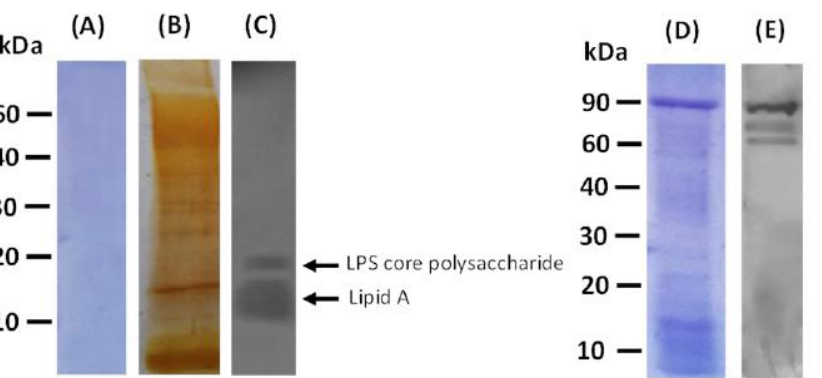
Figure 8. Immune responsiveness of PAGs antibodies to LPS and proteins from P. aeruginosa. ( A ) Coomassie blue-stained gel of the purified extracted P. aeruginosa LPS. ( B ) The silver-stained gel of purified LPS. ( C ) Western blot of purified LPS using serum from PAGs immunized rats as the primary antibody. ( D ) Coomassie blue-stained gel of prepared PAGs. ( E ) Western blot against PAGs proteins using serum from PAGs-immunized rats as the primary antibody.